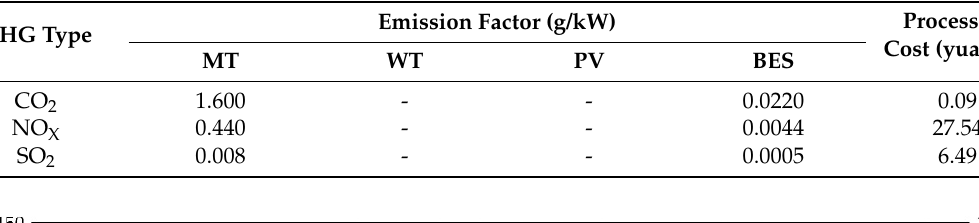
Table 2. The parameters of GHG emissions and process.